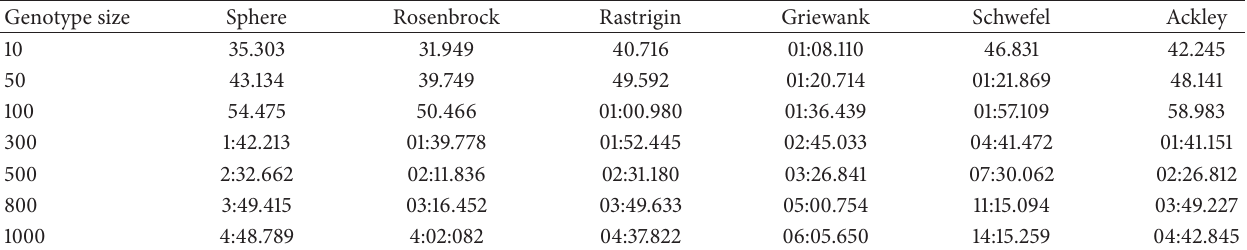
Table 6: CPU time results of the IMBO algorithm for the genotype sizes of 10, 50, 100, 300, 500, 800, and 1000; number of runs = 1; iteration =